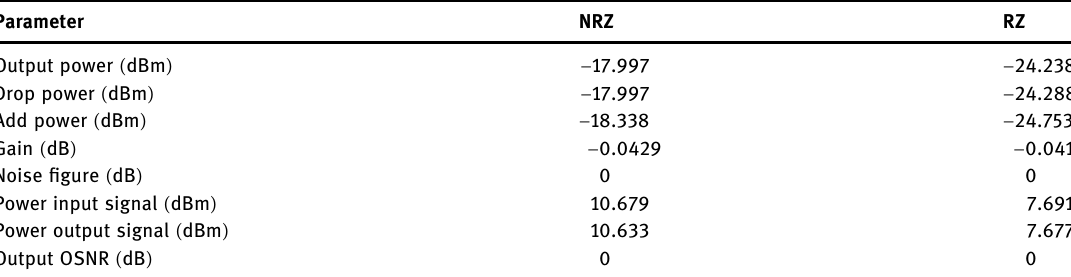
Table 5: The average parameters obtained from two proposals Parameter NRZ RZ Output power ( dBm )